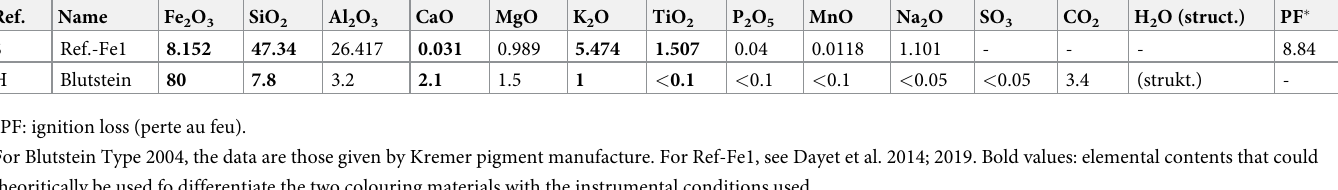
Table 3. Elemental composition (major elements) of the two pigments used in the experiments.